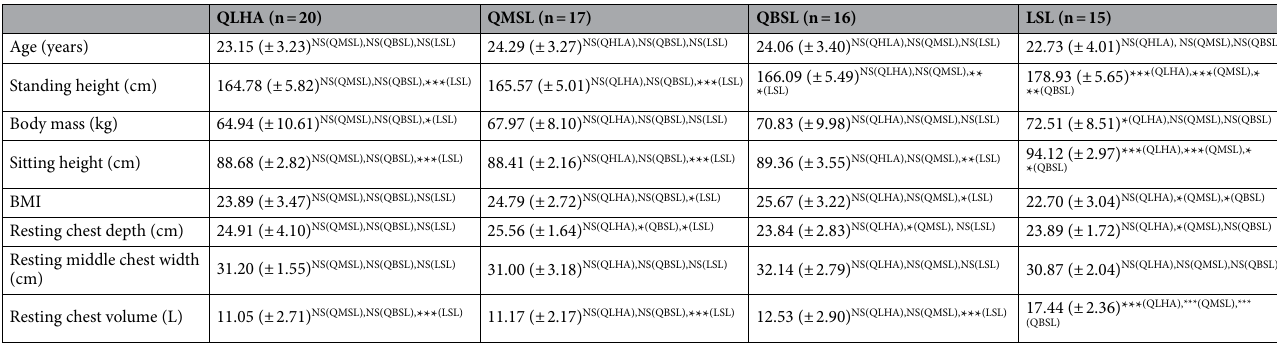
Table 1. Participant anthropometrics, with values given as mean ± SD. NS: not significant; *: p ≤ 0.05; **: p ≤ 0.01; ***: p ≤